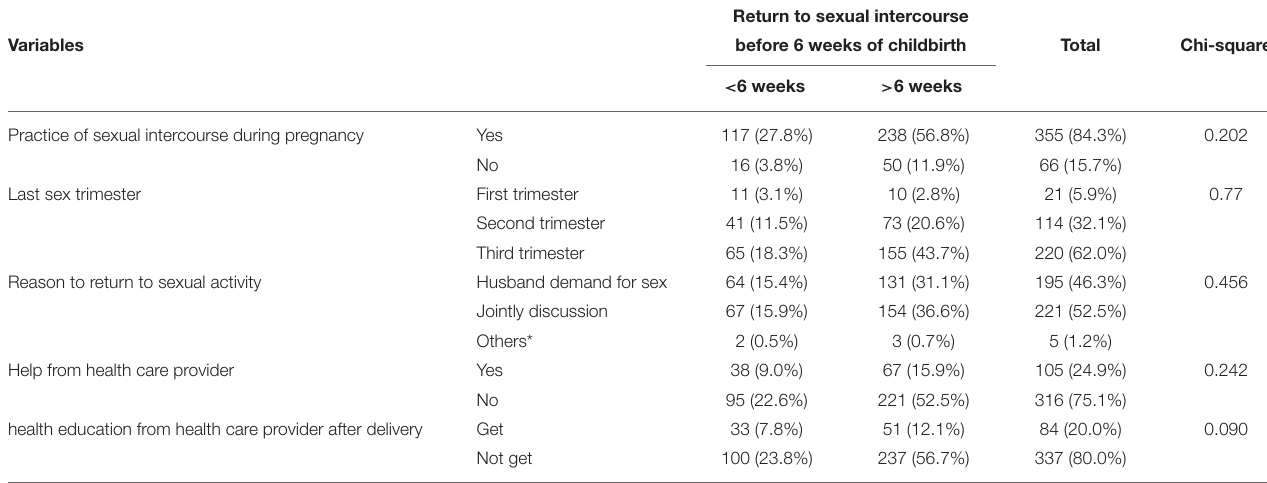
TABLE 4 | Sexual health characteristics of study participants who attending Salale University specialized and teaching hospital, from September to October 2021 ( n =